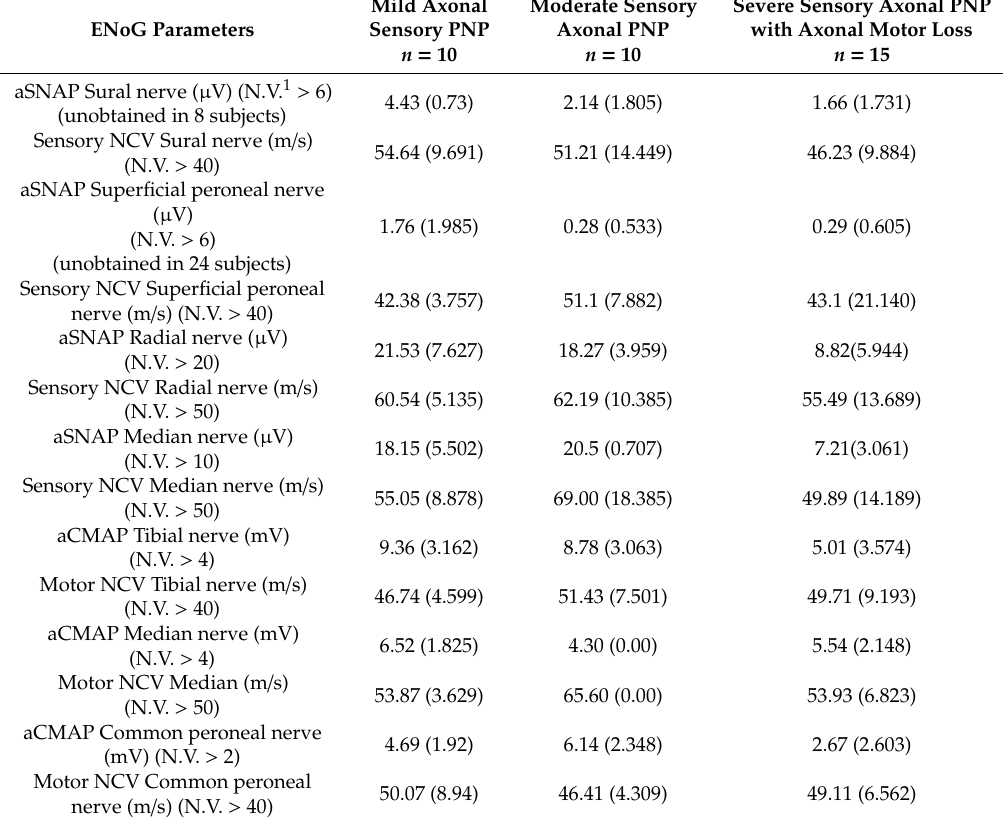
Table 4. Descriptive statistics of electroneurographic assessment (ENoG) parameters in the severity subgroups. N.V., normal values according to the laboratory; aSNAP, amplitude of sensory action potential; aCMAP, amplitude of compound muscle action potential. Results are represented as mean